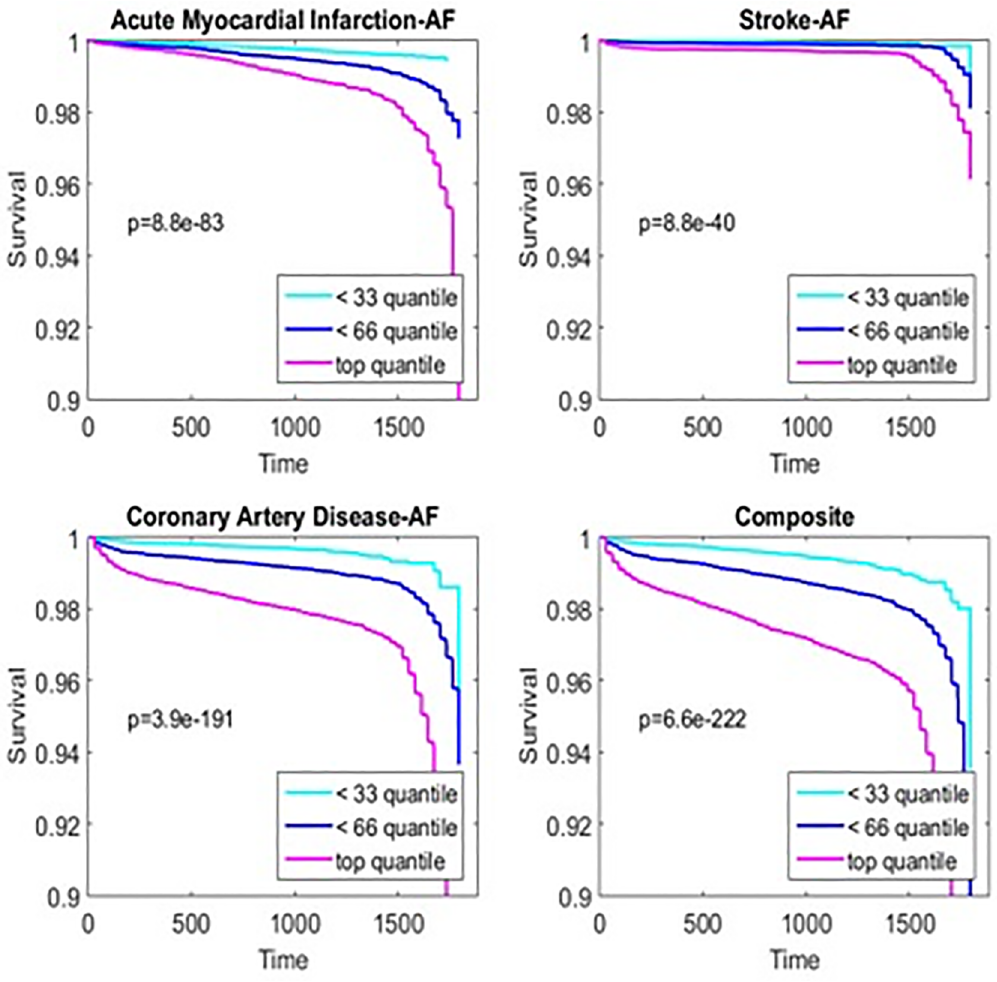
Fig 2. Predicted statin adherence and risk of cardiovascular outcomes. Predicted statin adherencewas divided into tertiles of predictedstatin adherence.The cumulativeevent free survival for each tertile of risk from Cox survival model is plotted for hospitalizations for acute myocardialinfarction, stroke, coronary artery disease,or a composite of all three. P-valuesrepresent results of log-ranktesting.